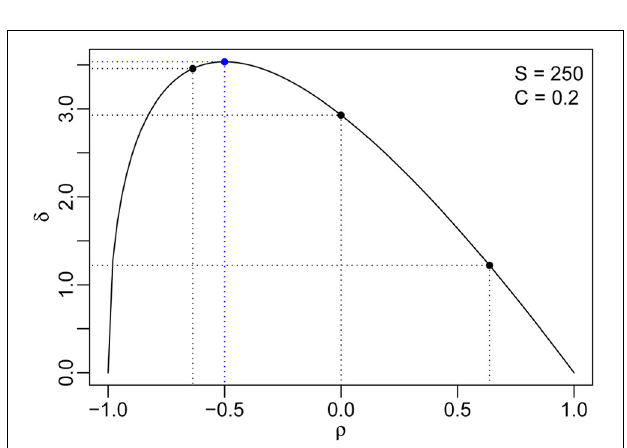
transitions are marked by vertical dashed lines. The three regions from left to right correspond to the ranges of d in which the equilibria are unstable, reactively stable, and non-reactively stable. We varied d from 0 to 15, with finer sampling in the regions around the expected phase transition ( x -axis). The standard deviation of the intra-specific interaction strengths, σ d , was set to 0, 0.5, and 1, shown as different shaded curves in each plot, from the lightest to the darkest.